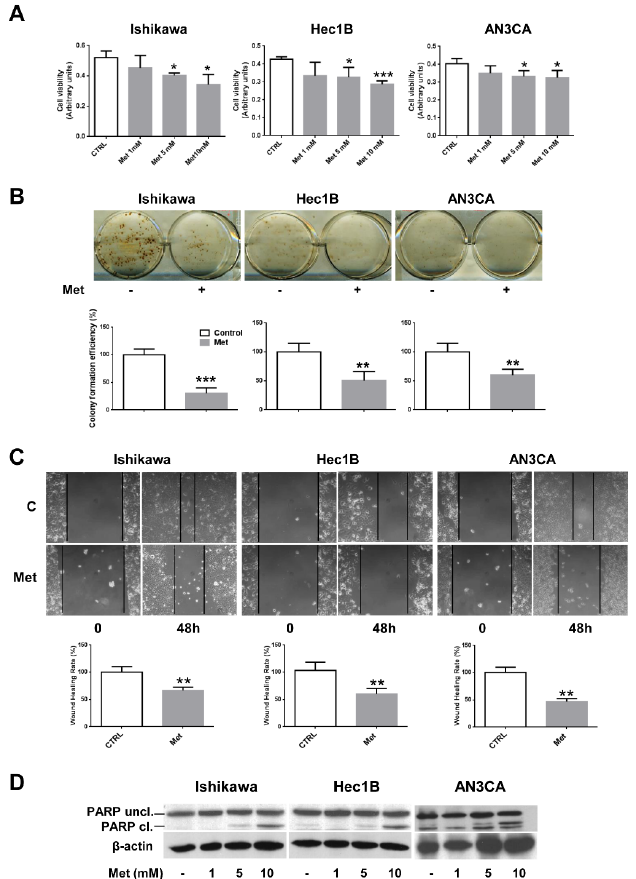
Figure 1. Metformin inhibits cell growth and viability in endometrial cancer cells. ( A ) Ishikawa, HEC1B, or AN3CA cells were seeded at a density of 5 × 10 3 cells in a 96-well plate. After 16 h, cells were treated or not with 1, 5, or 10 mM metformin. Cell viability was measured after 48 h using the MTT assay. Values represent the mean absorbance at 570 nm ± SD of triplicates of three inde- pendent experiments. * indicates a p -value < 0.05; *** indicates a p -value < 0.001. ( B ) Ishikawa, HEC1B, or AN3CA cells were seeded onto six-well plates at a density of 1 × 10 3 cells per well. After cell attachment, 5 mM metformin was added or not to the wells for 4 h. The cells were then cultured with fresh medium. After 2 weeks, the resultant colonies were fixed with 4% paraformaldehyde and stained with hematoxylin. The colonies were then photographed, counted under a microscope, and colony efficiency formation was calculated. ** indicates a p -value < 0.01; *** indicates a p -value < 0.001. ( C ) Ishikawa, HEC1B, or AN3CA cells (1 × 10 6 per well) were seeded in six-well plates and allowed to form a cell monolayer for 24 h. Cell layers were wounded with a micropipette tip and then incubated in fresh culture medium containing or not 5 mM metformin for 48 h. Cell migration toward the wounded area was observed, photographed, and measured. Experiments were per- formed three times in triplicate. Graphs show the percentage of wound healing rate. ** indicates a p -value < 0.01 . ( D ) Ishikawa, HEC1B, or AN3CA cells were treated or not with 1, 5, or 10 mM metformin for 48 h. Total cellular proteins were extracted and Western blot experiments were performed with antibodies against PARP and β-actin.